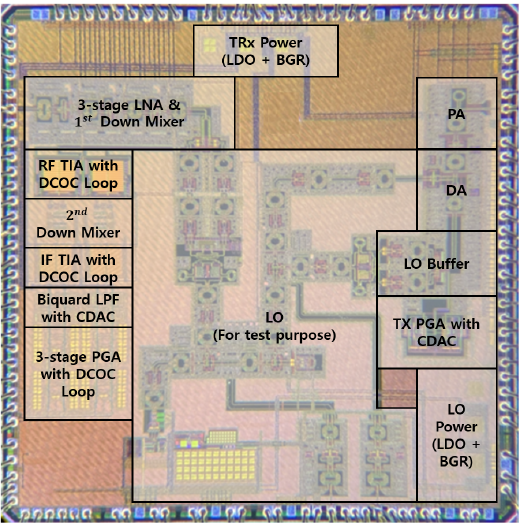
Figure 30. Transceiver die micrograph for RADAR System.